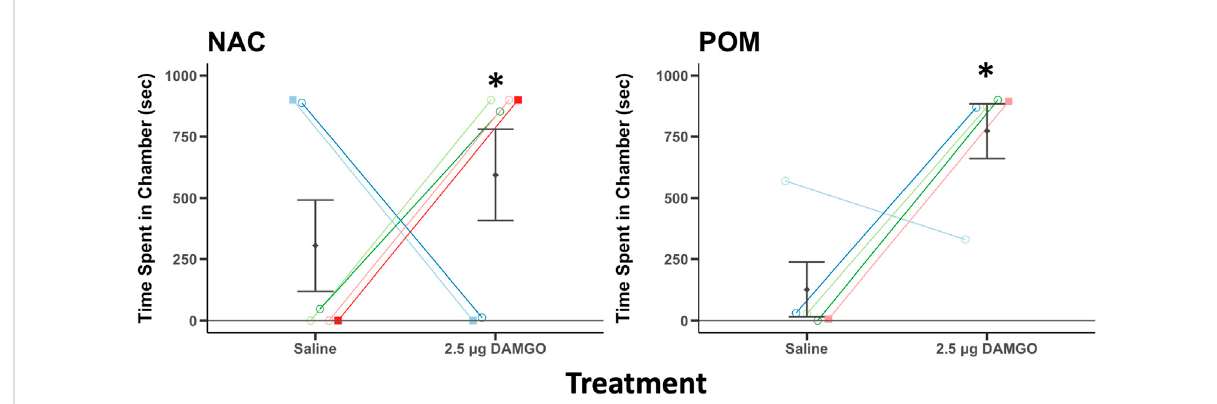
FIGURE 5 MOR stimulation in NAC and POM induces a conditioned place preference. Time spent in a chamber that had been paired previously with intra NAC or intra POM infusions of saline and 2.5 μ g DAMGO. Mean ± sem is indicated for each group. Individual repeated data points are shown for males (circles) and for females (squares). * indicates that the difference score between the time spent by each individual on the side that had been paired with 2.5 DAMGO minus the side that had been paired with saline differed signi fi cantly from zero ( p < 0.05). Note: for analysis we subtracted the time spent on the saline side from the time spent on the DAMGO paired side and compared this statistically to zero (which would re fl ect no preference). We present here the individual data points to provide readers with information on each individual. See results for additional statistical